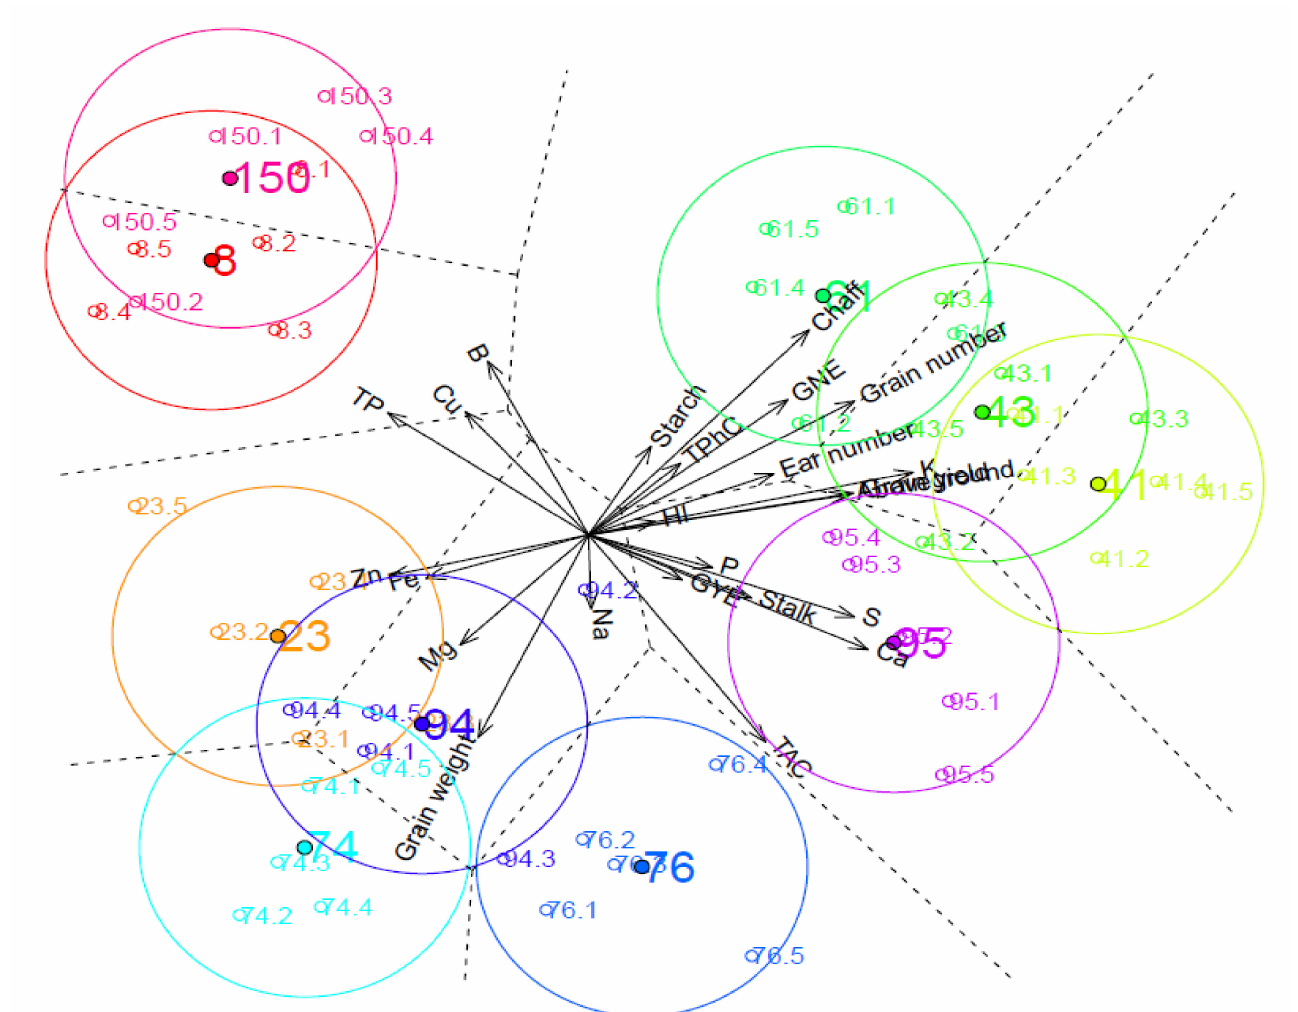
Figure 1. Canonical biplot for the wheat production, grain yield, non-mineral and mineral quality components of 10 wheat genotypes grown under elevated CO 2 and high temperature. GNE : grain number ear − 1 ; GYE : grain yield ear − 1 ; HI : harvest index; TAC : total antioxidant capacity; TP : total protein; TPhC : total phenolic compounds. Individuals are represented by empty dots, labelled based on their genotype and numbered as one of the five replicates ( n = 5) for each group. Filled points represent projections of the averages of the genotypes on the biplot with confidence circles based on Bonferroni’s post-hoc tests. Dotted lines indicate the boundaries of the regions for each group on the Voronoi